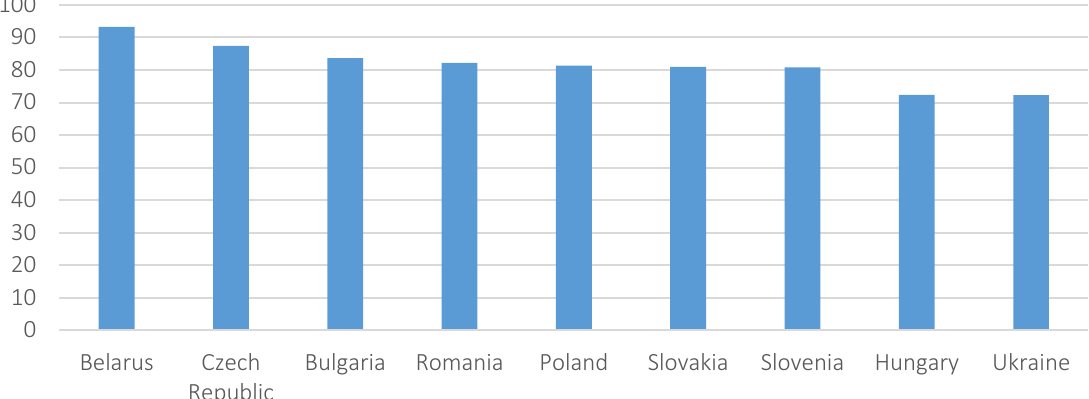
Figure 10. Investment funds’ (M3–M0) share in total money supply in Ukraine and peers, as at January 2019,